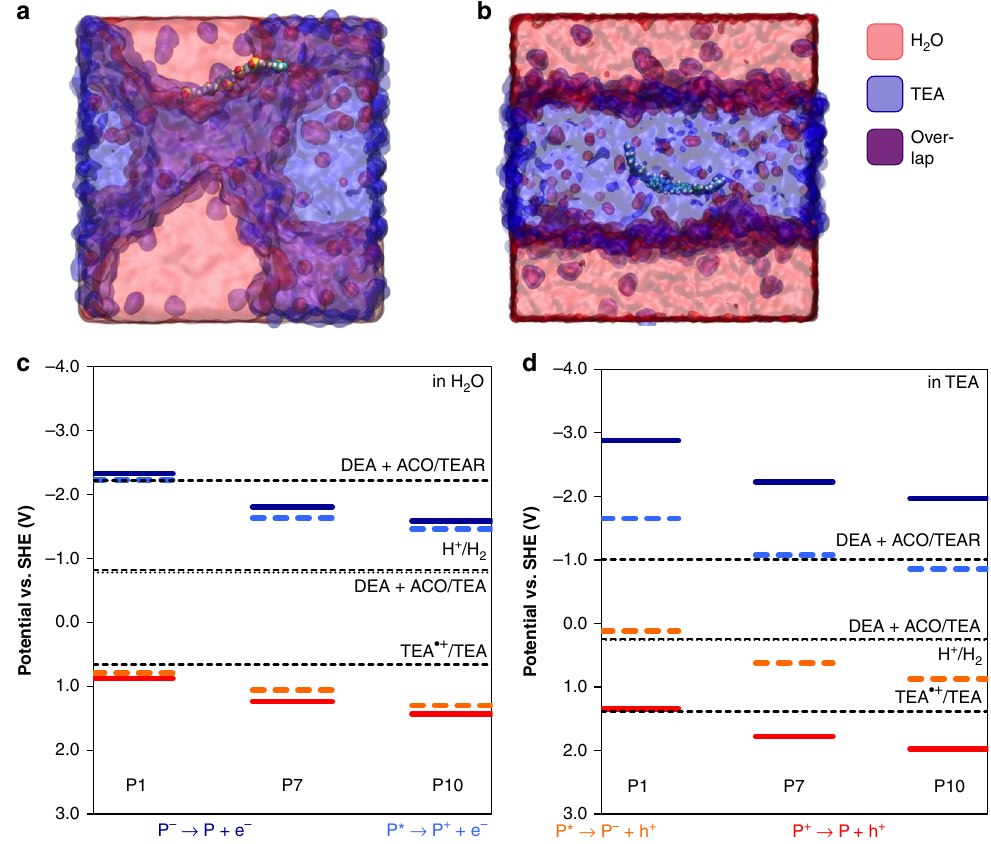
Fig. 5 Molecular dynamics simulations and energy level calculations in water and mixed water/TEA environments. a , b Snapshots of atomistic molecular dynamics simulations of oligomers of a the polar polymer P10 and b a non-polar fl uorene polymer, as a model for P1, both in a mixture of TEA (blue) and water (red). While the non-polar fl uorene polymer hides in the TEA phase, the amphiphilic P10 polymer resides in a domain containing both TEA and water, typically close to the TEA – water interface. c , d Calculated ionization potential (IP, red solid line) and electron af fi nity (EA, blue solid line) for ground- state oligomers of P1, P7, and P10 together with the exciton electron af fi nity (EA*, orange dashed line) and ionization potential (IP*, blue dashed line), in comparison with the potentials for proton reduction (H 2 /H + ), overall TEA oxidation (DEA + ACO/TEA), the fi rst TEA oxidation step (TEA (cid:129) + /TEA) and the second oxidation step of the TEA oxidation product (DEA + ACO/TEAR), using a c water or d TEA solvent